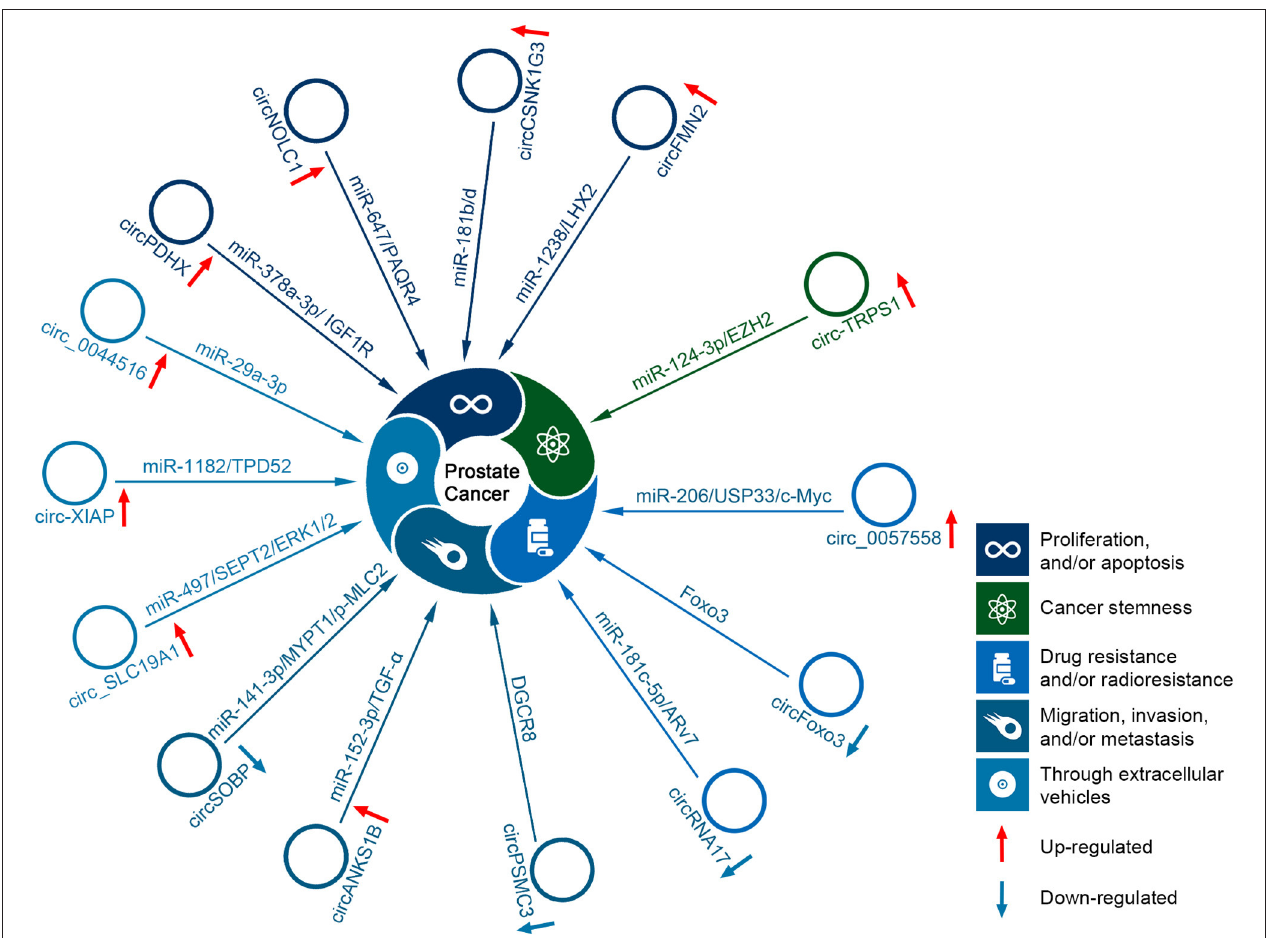
FIGURE 3 | Schematic illustration of the representative functional